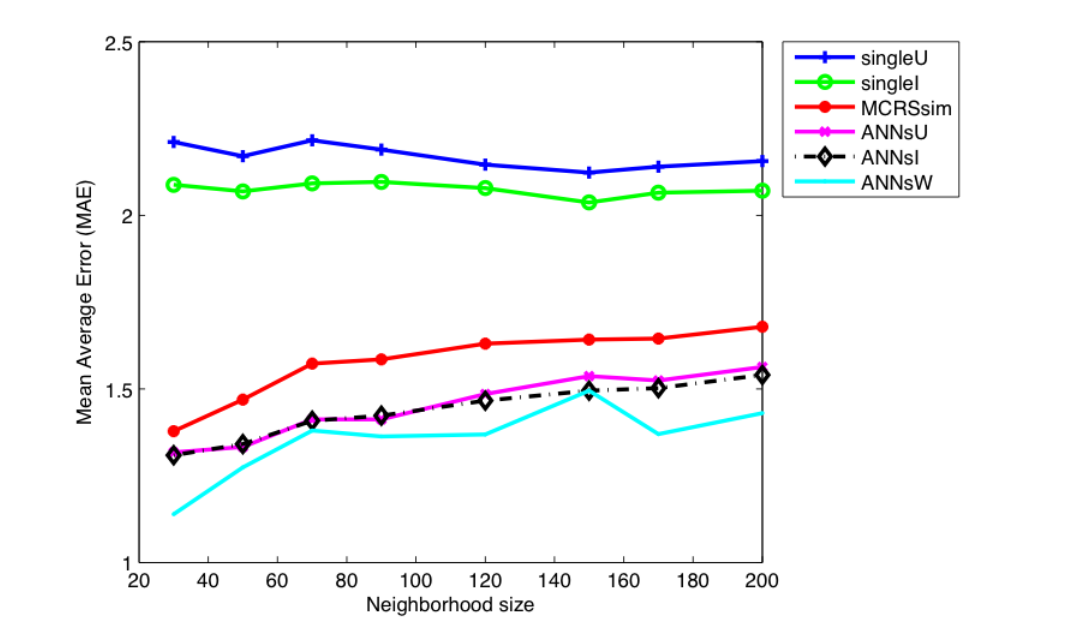
Figure 5. Curves of the mean average error (MAE) against the neighborhood